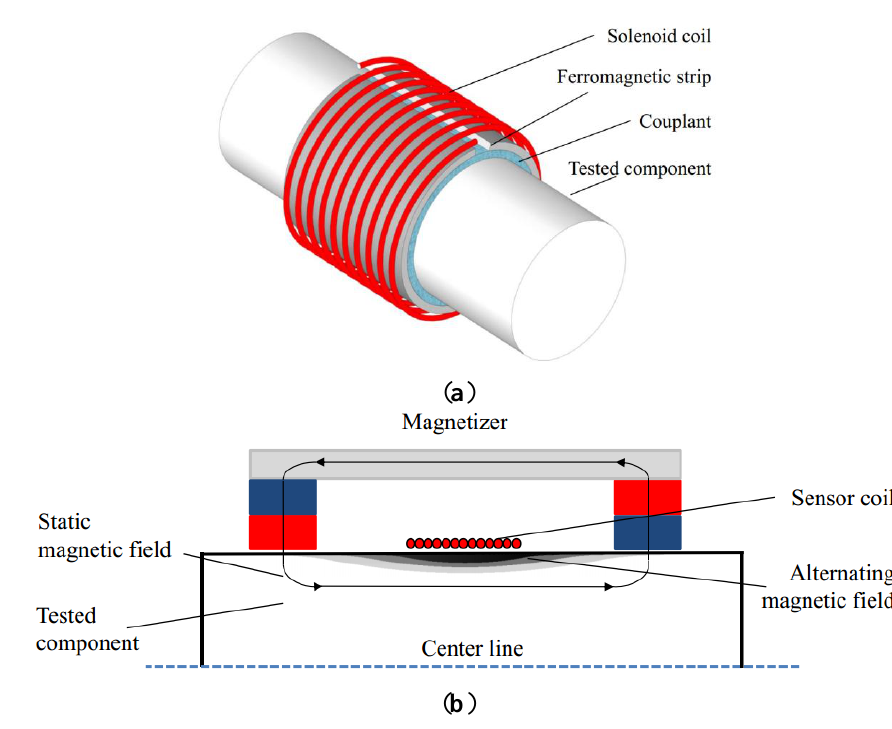
Figure 2. The structures of MsSs used in GWT. ( a ) The contact MsS. ( b ) The non-contact